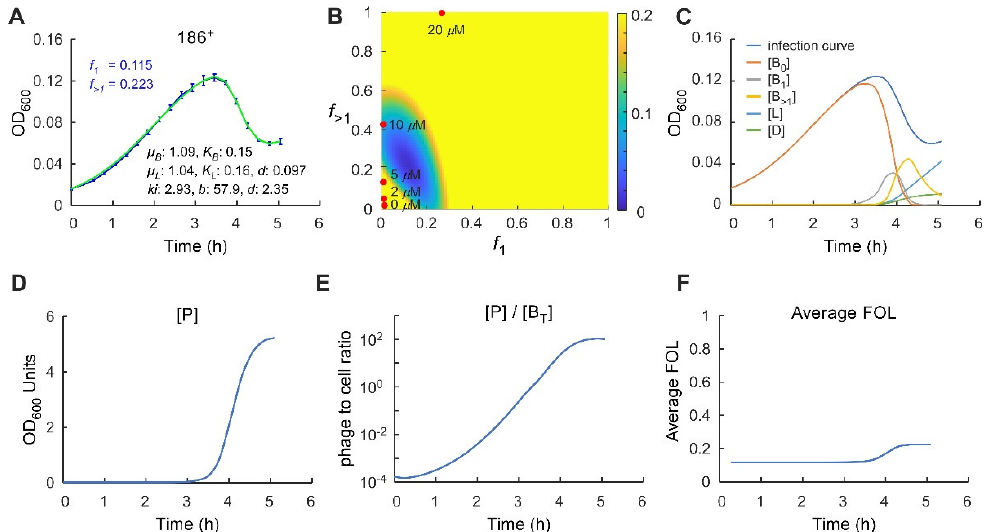
Figure 5. Analysis of 186 + phage infection time course using the multiple-infection lysogenisation model. ( A ) Fitting of the 186 + phage infection time course using the multiple-infection lysogenisation model. Data are taken from Figure 2A. Error bars represent standard deviation, n = 6. For data fitting, three rounds of 50,000 iterations of fitting were performed, and the best fit from each round was plotted. ( B ) Heatmaps showing the range of f 1 and f >1 values that produce a good fit (blue). The best fit f 1 , f >1 values for 186 cII − phage infection at each IPTG concentrations are overlayed. None of the fixed CII concentration precisely mimic CII expression in a phage 186 + infection. However, there are some overlap in f 1 , f >1 ranges between 10 µM IPTG and 186 + infection. ( C – E ) The concentrations of different species, the relative phage to cell ratio, and ( F ) the average f over the course of the 186 + infection as predicted by the multiple-infection lysogenisation model.